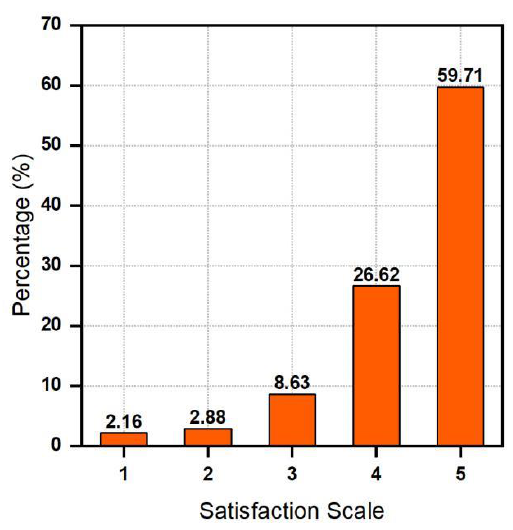
Figure 8 . Thermal satisfaction vote. Figure 8. Thermal satisfaction vote.